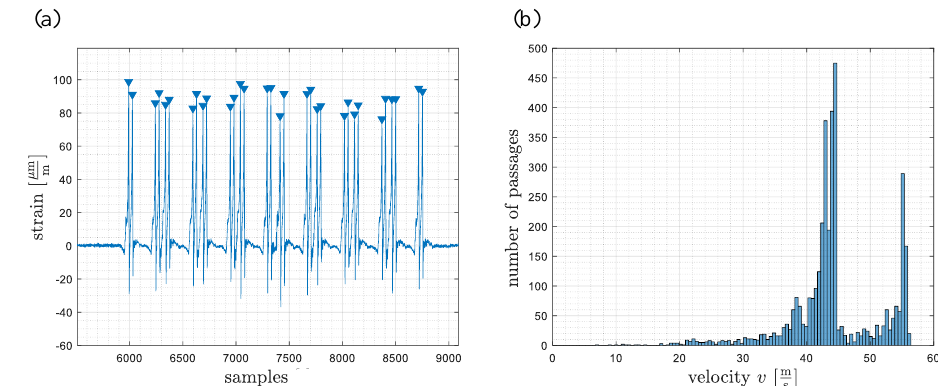
Figure 5. ( a ) Signal of the wheel load measuring point with detected peak values marked with blue triangles ( b ) Histogram of determined mean train velocities for all 3745